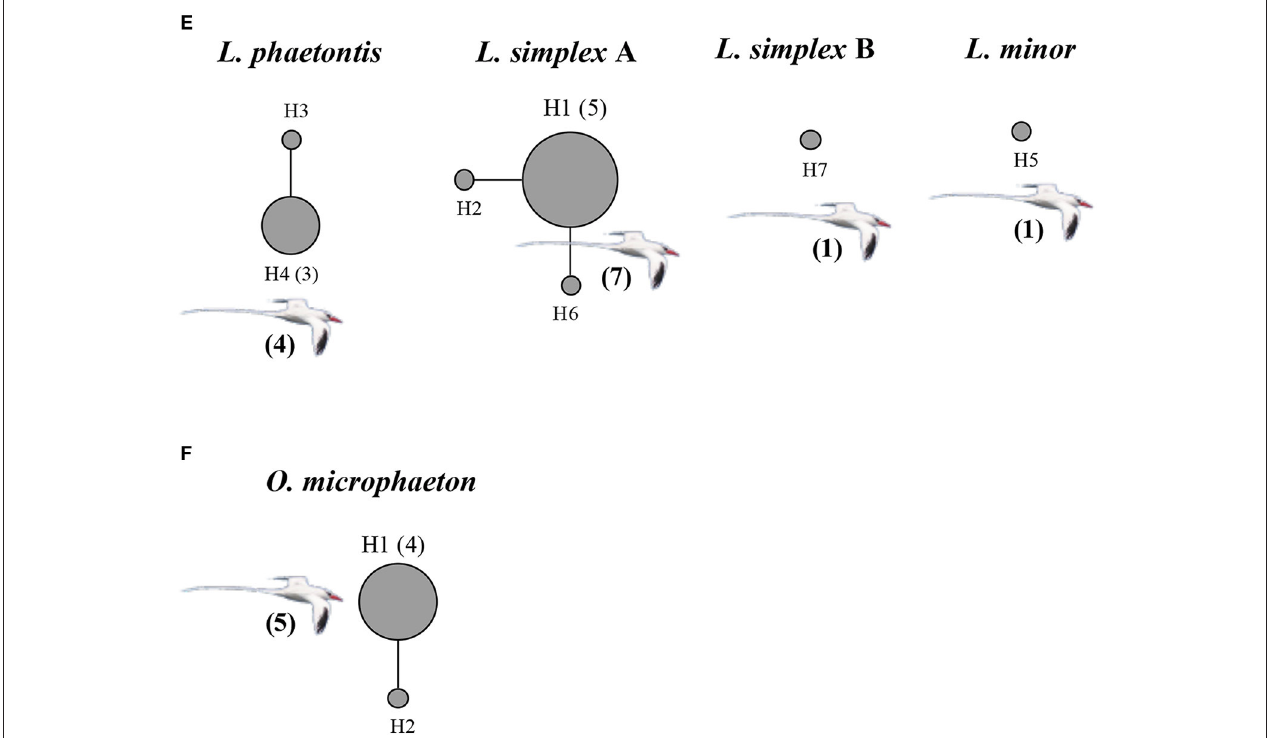
FIGURE 2 | Statistical parsimony haplotype networks for seabird feather mites Zachvatkinia (A) , Microspalax (B) , Brephosceles (C) , Plicatalloptes (D) , Laminalloptes (E) , and Onychalloptes (F) from the Cape Verde Islands based on the concatenation of two mitochondrial genes (12S and 16S). Haplotypes are colored according to the hosts harboring the mites (green – C. edwardsii , blue – P. boydi , red – B. bulwerii , purple – O. castro , orange – P. feae , and gray – P. aethereus ). Circle sizes are proportional to the number of individuals possessing each haplotype, indicated in brackets; when no number is indicated, only one mite individual presented this haplotype. Black dots represent mutational steps. The number of mite individuals analyzed per each bird species is shown in brackets.